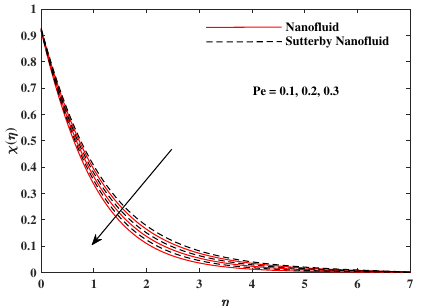
Figure 14. χ ( η ) fluctuate with Pe and Lb .